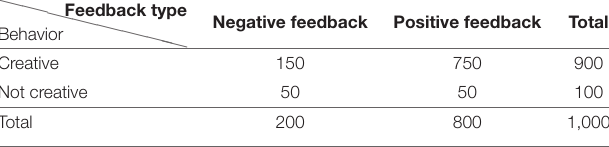
TABLE 2 | Feedback type and student creativity